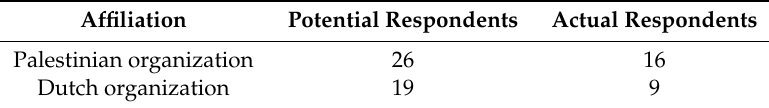
Table 4. Affiliation of potential and actual survey